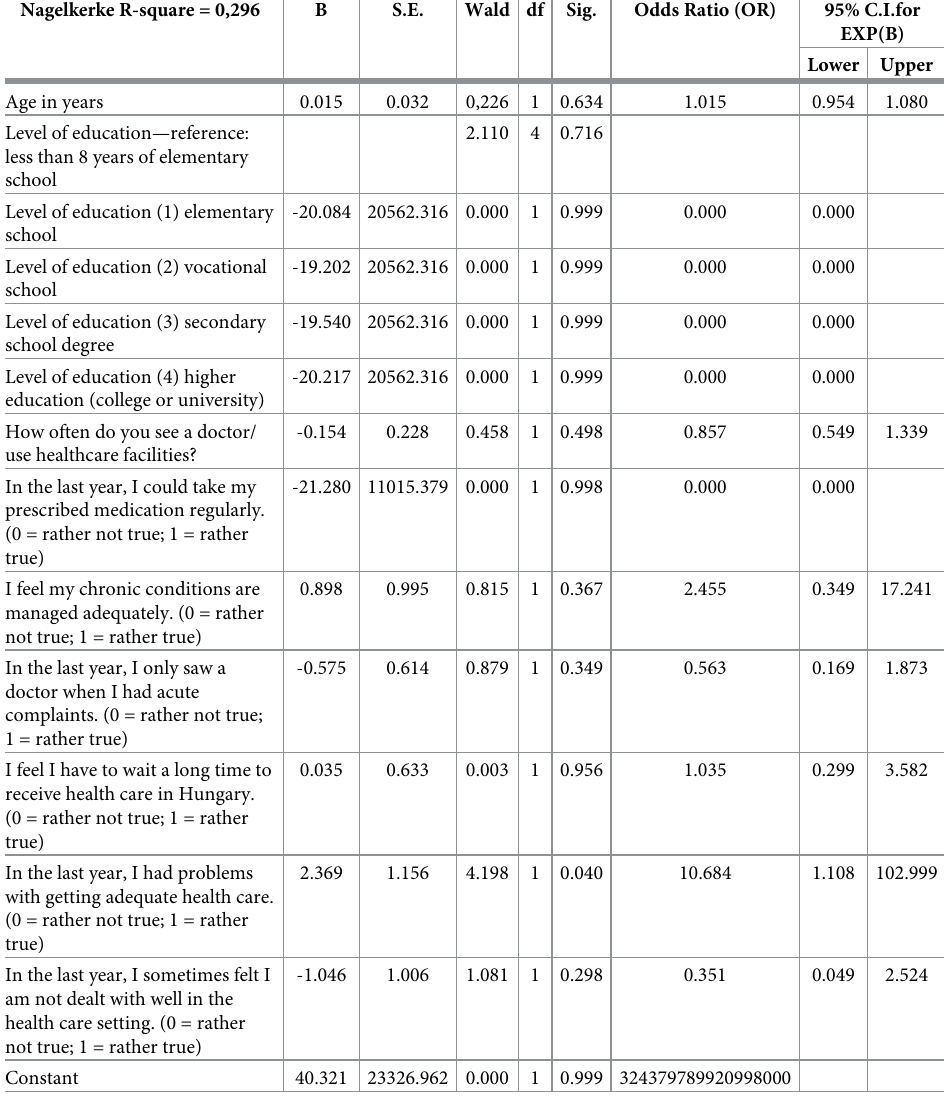
Table 6. The logistic regression explanation model of the I definitely prefer in-person doctor-patient consultations variable. Nagelkerke R-square = 0,296 B S.E. Wald df Sig. Odds Ratio (OR) 95% C.I.for Age in years 0.015 0.032 0,226 1 0.634 1.015 0.954 1.080 Level of education—reference: 2.110 4 0.716 less than 8 years of elementary school Level of education (1) elementary -20.084 20562.316 0.000 1 0.999 0.000 0.000 school Level of education (2) vocational